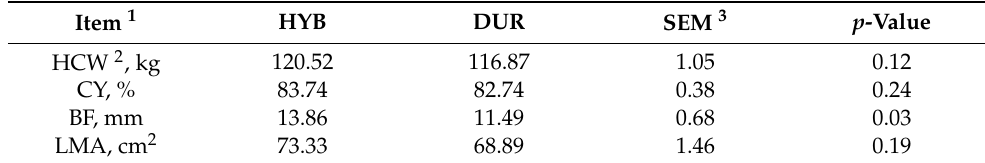
Table 6. Carcass traits of pigs of different genetic lines.